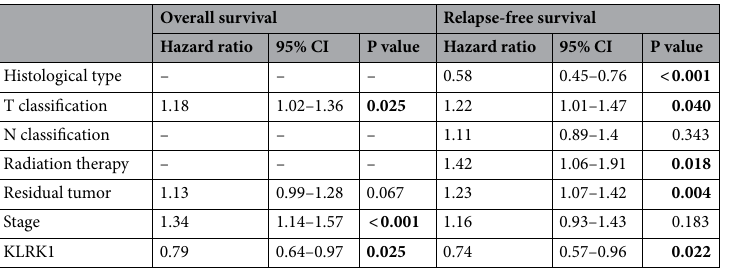
Table 5. Multivariate analysis of overall survival and relapse free survival in patients with lung